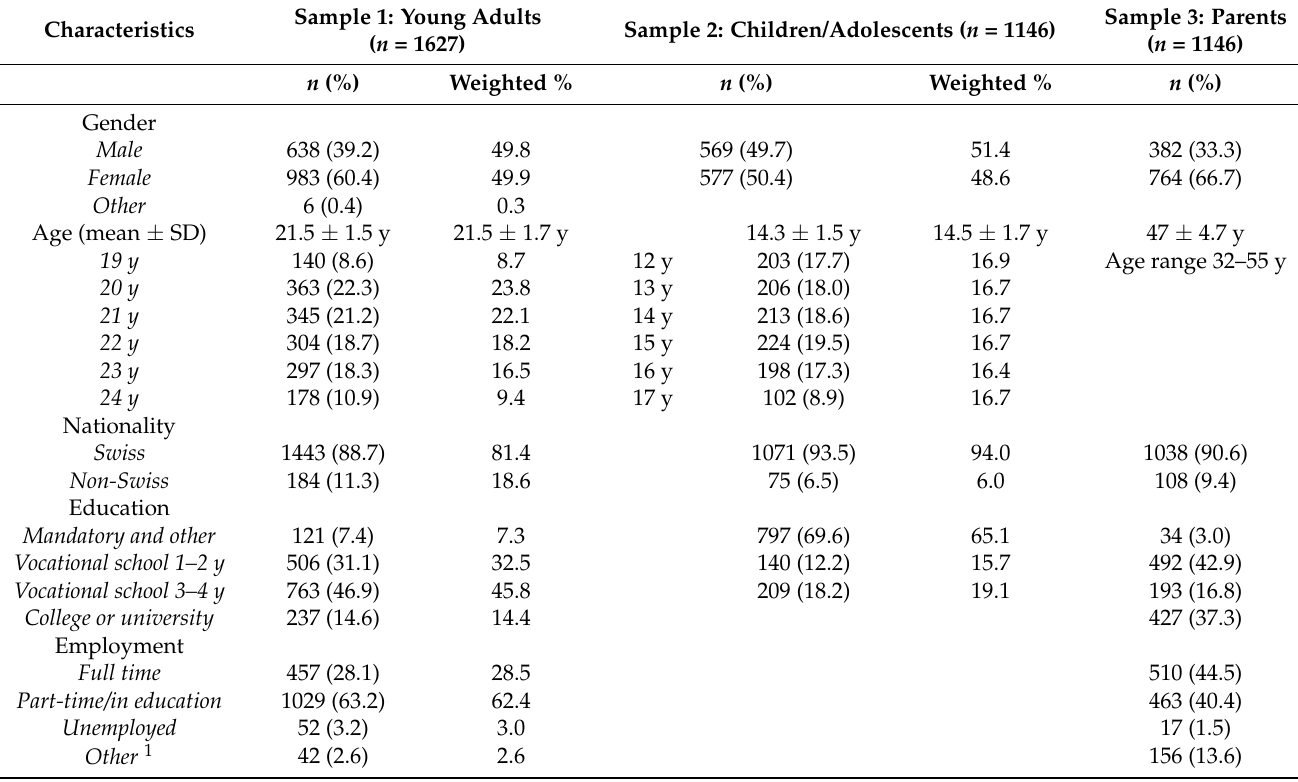
Table 1. Sociodemographic characteristics of the study